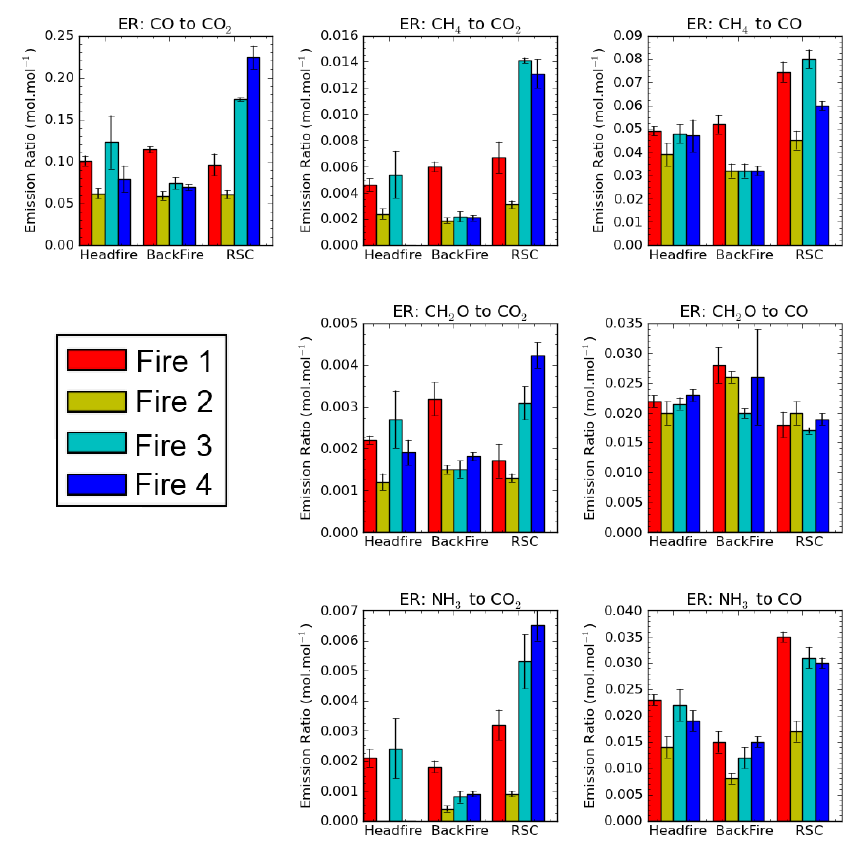
Fig. 8. Emission ratios [ER x / y ] for CO 2 , CO, CH 2 O and NH 3 for the backfire, headfire and residual smouldering combustion (RSC) stages of Fires 1, 2, 3 and 4 (see Table 1 for fire details). ERs to both CO and CO 2 are shown, and missing values indicate cases where the derived ER x / y was poorly constrained based on a low coefficient of determination ( r 2 ) between the two relevant trace gas column amounts. This may be due in some cases to short periods where the plume blew outside of the optical path, and in others to instances where the relationship between the two trace gas column amounts is not well described by a linear fit. ER uncertainties are given by the error bars, derived from the 95% confidence limits in the slope of the least squares linear best fit to the trace gas column amounts (see Fig.